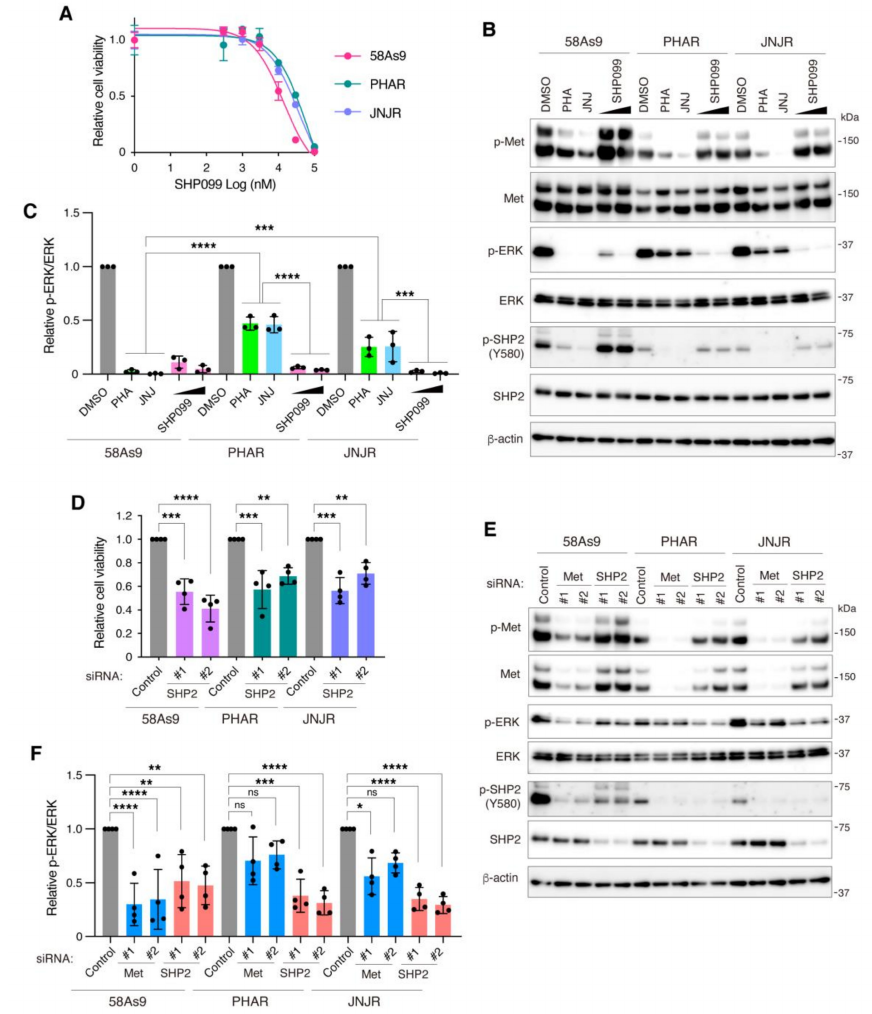
Figure 6. Blocking SHP2 overcomes resistance to Met inhibitors in DGC cells. ( A ) Parental 58As9 and Met inhibitor resistant sublines, PHAR and JNJR cells, were treated with increasing concentrations of the allosteric SHP2 inhibitor SHP099 for 6 days and the cell viability was examined. Bars, SD ( n = 3). ( B ) 58As9, PHAR, and JNJR cells were treated with Met inhibitors, PHA-665752 (PHA) and JNJ-38877605 (JNJ) at 300 nM, or SHP099 at 10 or 30 µ M for 2 h and subjected to immunoblot analysis. ( C ) Relative levels of ERK phosphorylation were determined by quantitative analysis of the immunoblotting data. Bars, SD ( n = 3). ***, p < 0.001; ****, p < 0.0001. ( D ) 58As9, PHAR,